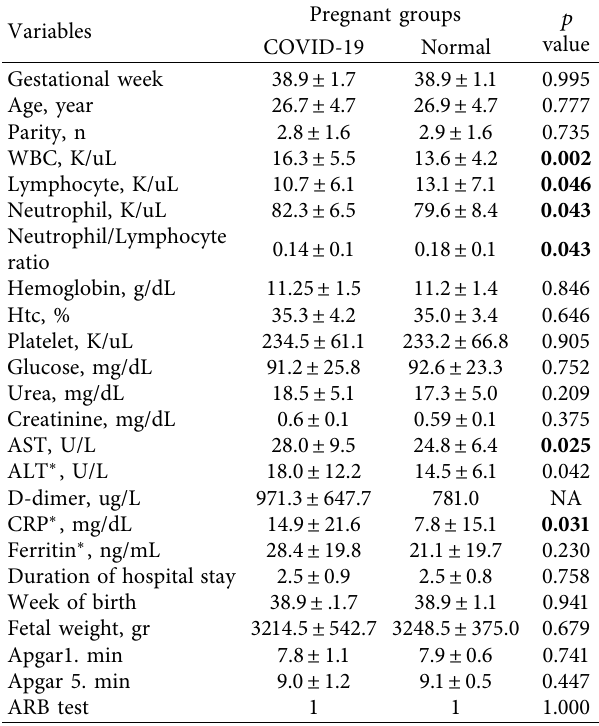
Table 1: Comparison of biochemical variables between COVID and normal pregnant